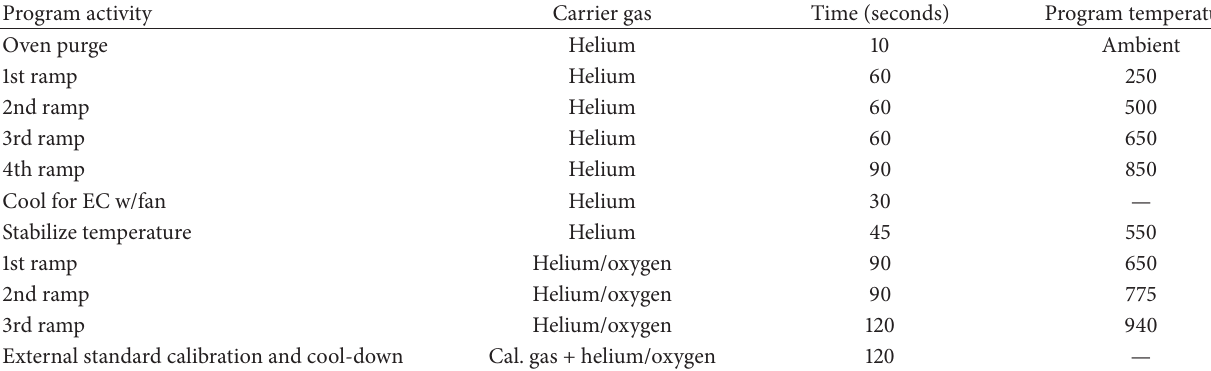
Table 1: Thermal program of EC/OC